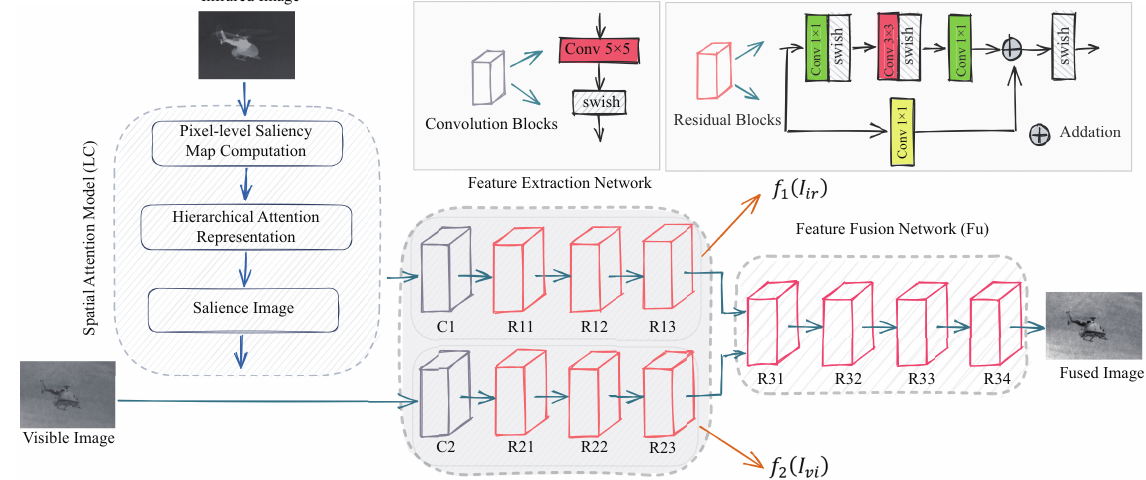
Figure 1. Architecture of the proposed infrared and visible image fusion network.